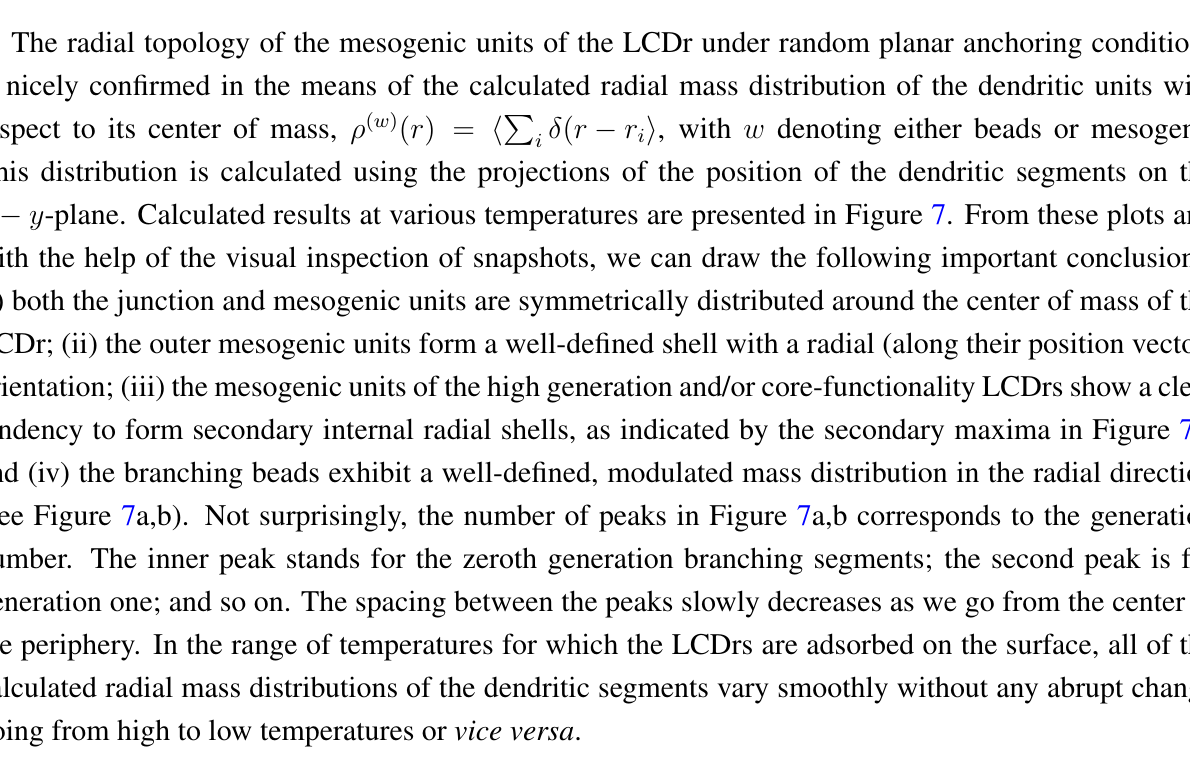
Figure 6. Snapshots of adsorbed LCDrs under random planar anchoring conditions at T ∗ = 0 . 6 . ( a ) G beads are not shown. ( e ) G